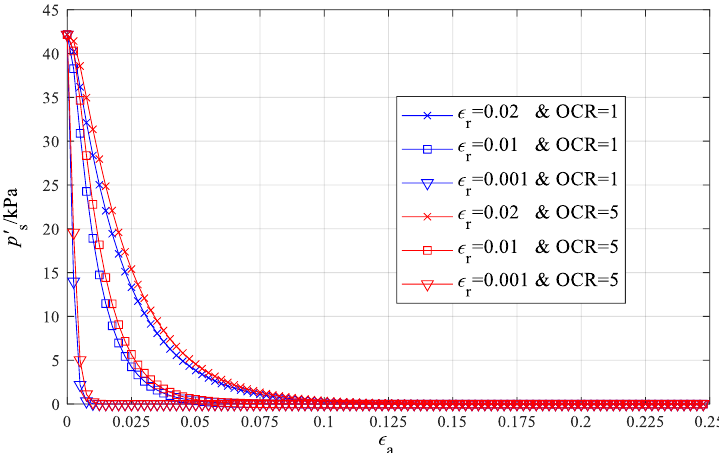
Figure 6. Structure strength decay influencing by the reference strain ε r . (c) Influence of spacing ratio r .